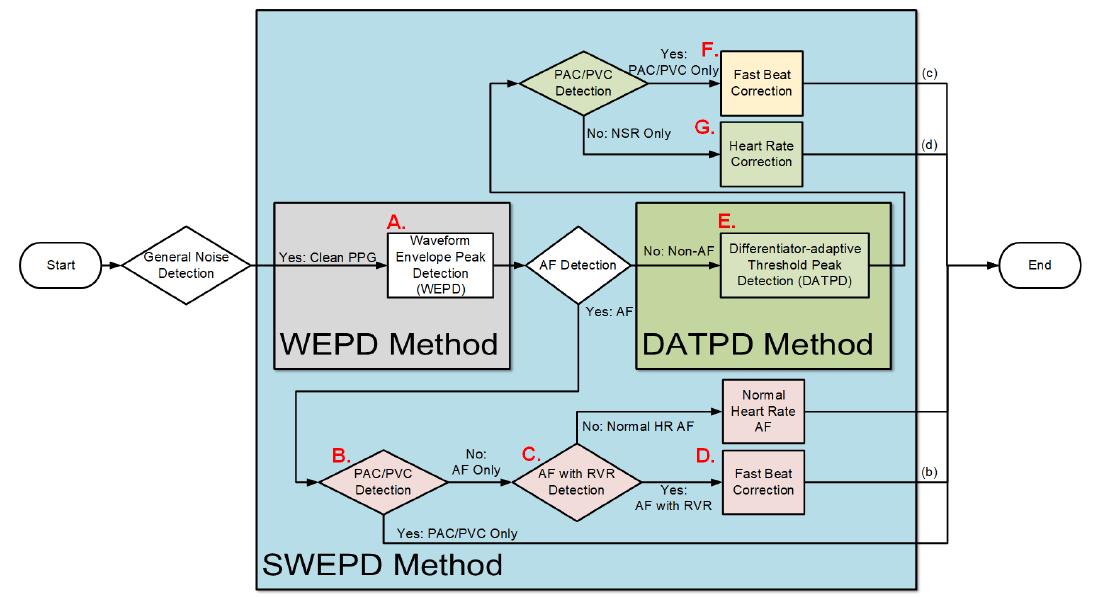
Figure 1. Flow chart of the proposed sequence including our new peak detection algorithm and a new peak correction method. Step A: perform PPG peak detection on the clean PPG using the WEPD peak detection algorithm described in Section 2.2.2. Step B: if AF detected, perform PAC/PVC detection on the derivatives of heart rates to ensure AF was not falsely detected, as described in Section